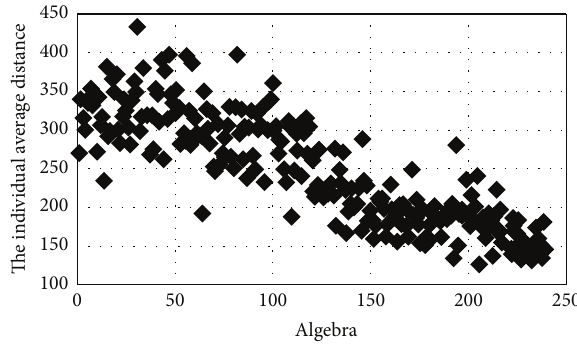
Figure 16: The individual average distance in the process of